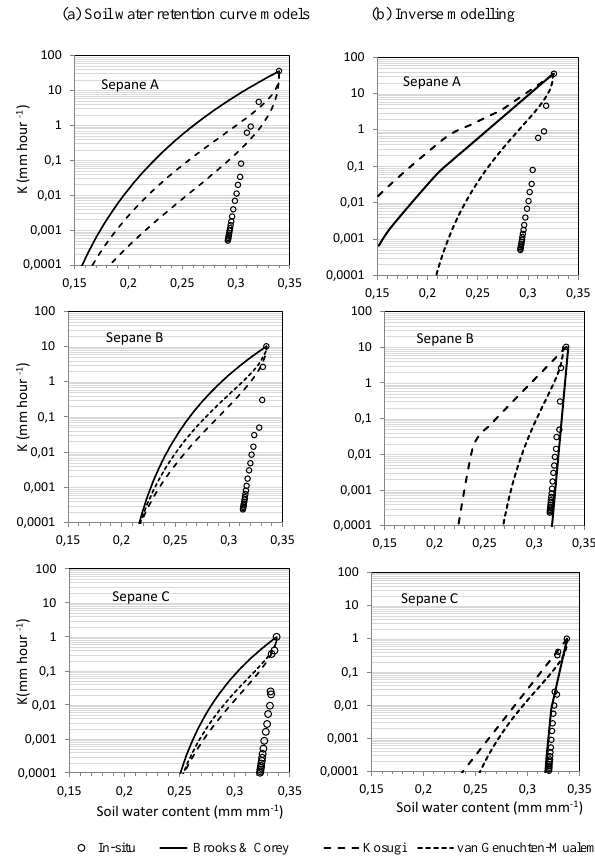
Figure 5 Models predictions of in-situ hydraulic conductivity based on the soil water Fig. 5. Models predictions of in situ hydraulic conductivity based on retention curve (a) and inverse modelling (b) for the Tukulu diagnostic horizons. the retention curve and inverse modelling for the Tukulu diagnostic horizons.